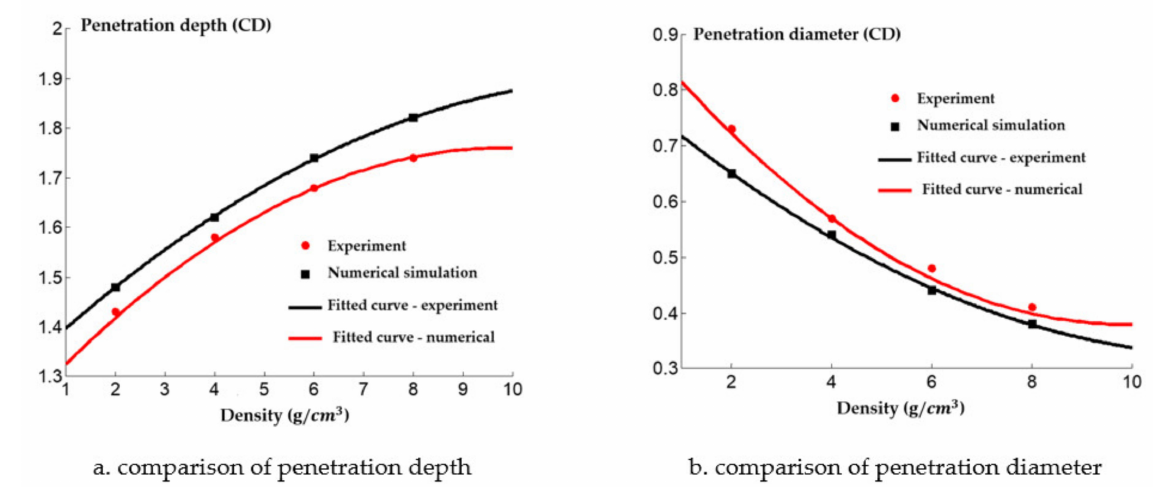
Figure 21. Penetration of reactive charge liners with different densities into a steel